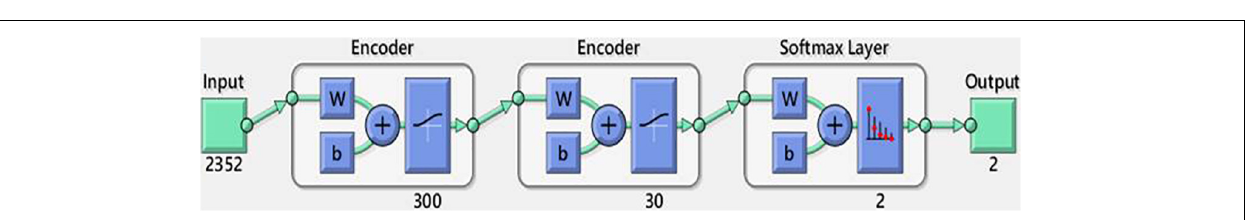
FIGURE 6 | Diagram of the SAE.